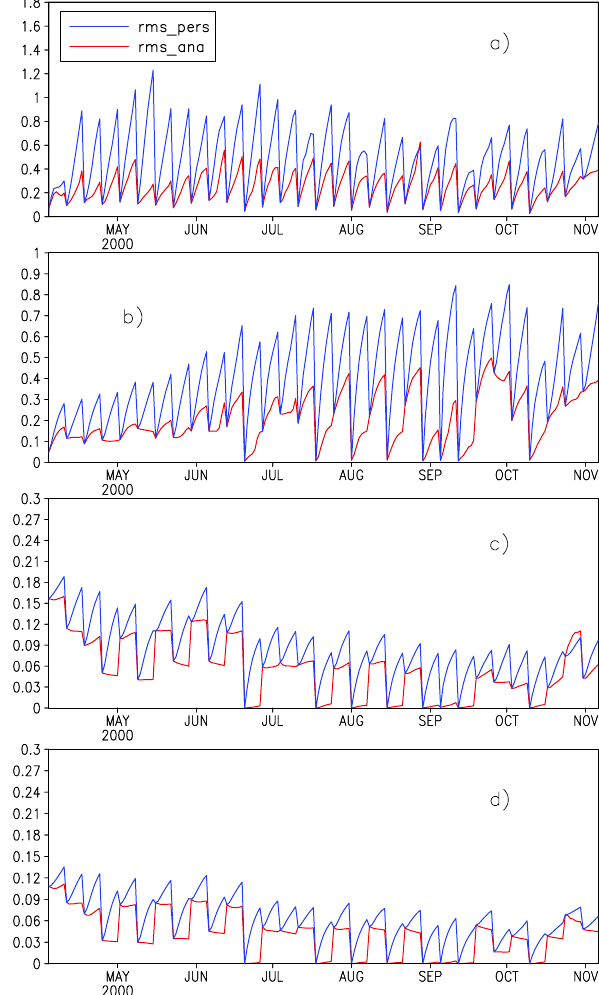
Fig. 9. Root mean square temperature forecast (red line) and per- sistence (blue line) errors at (a) 5 m; (b) 30 m; (c) 280 m and (d) 400 m for the 31, 10-day forecasts carried out from April to October